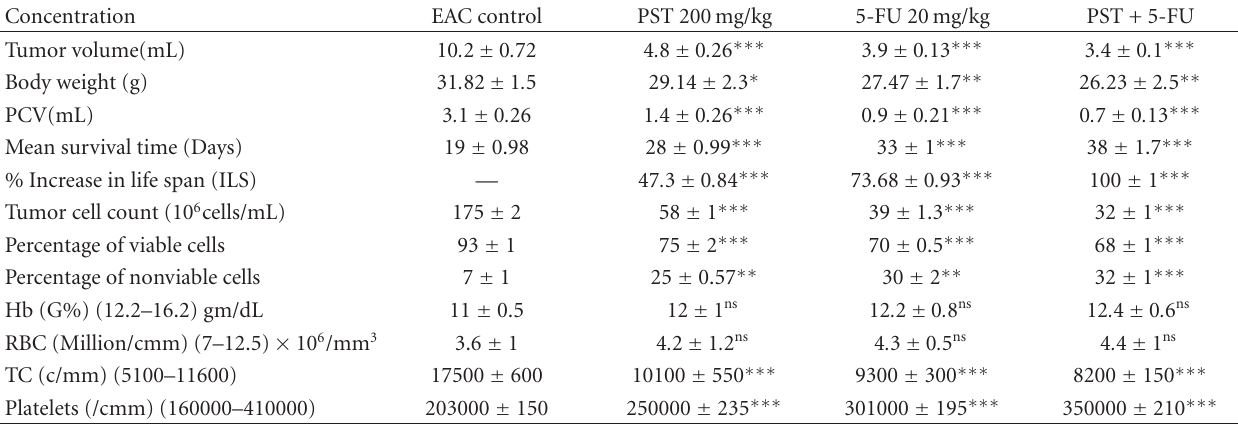
Table 4: Tumor and hematological characteristics in mice injected with EAC on day 1 followed by drug administration for 14 days and dissected on 15th day (Group 2).